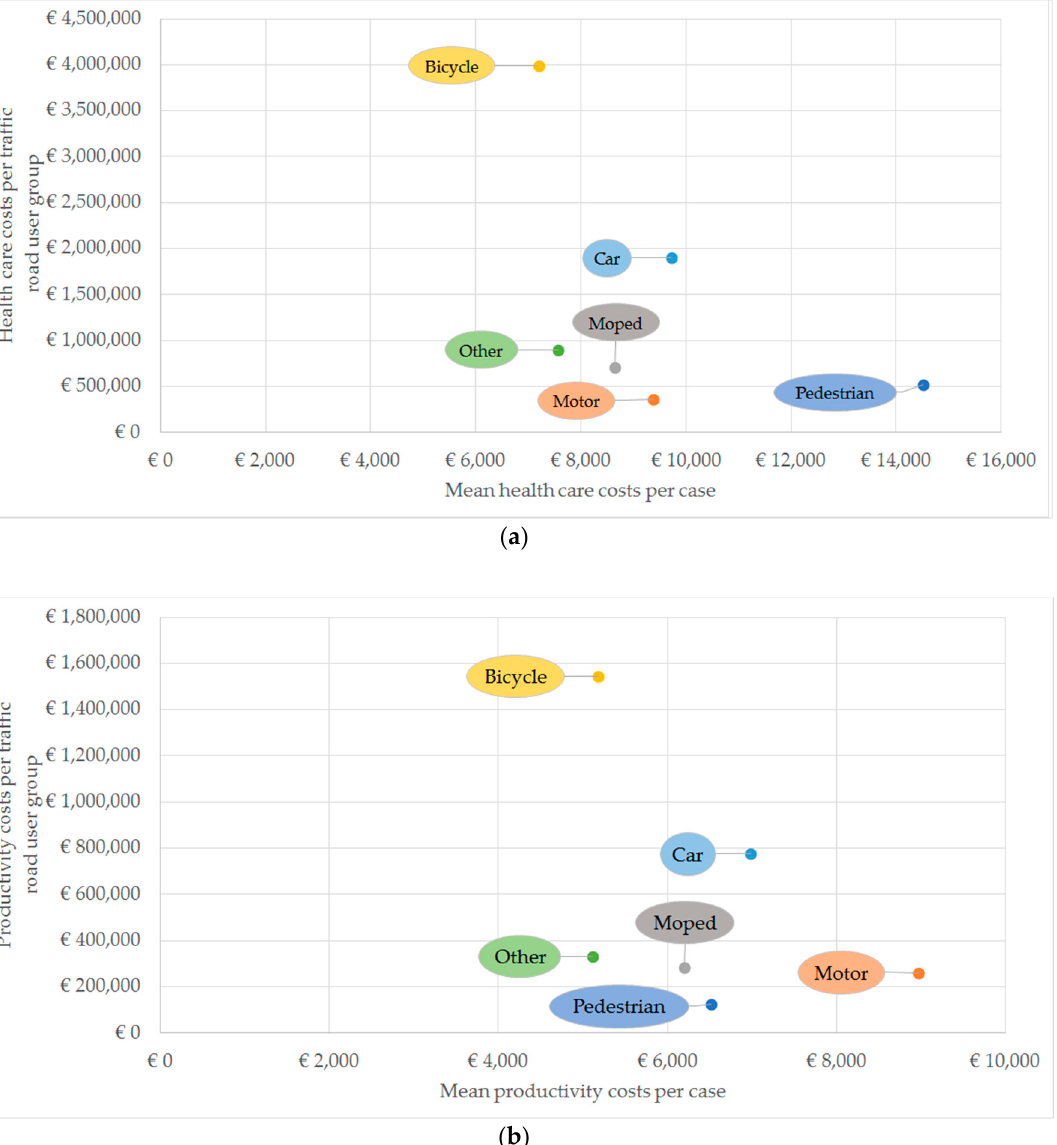
Figure 1. ( a ) Mean health care costs per case and total productivity costs for 6 road type users, 2017 EUR; ( b ) Mean productivity costs per case and total productivity costs for 6 road type users, 2017 EUR